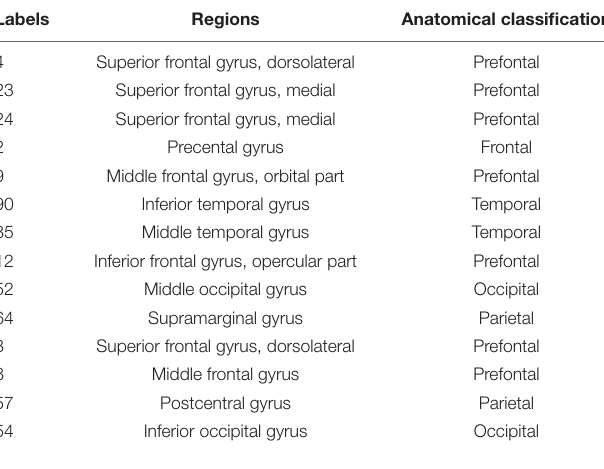
TABLE 2 | Hub regions of the metabolic